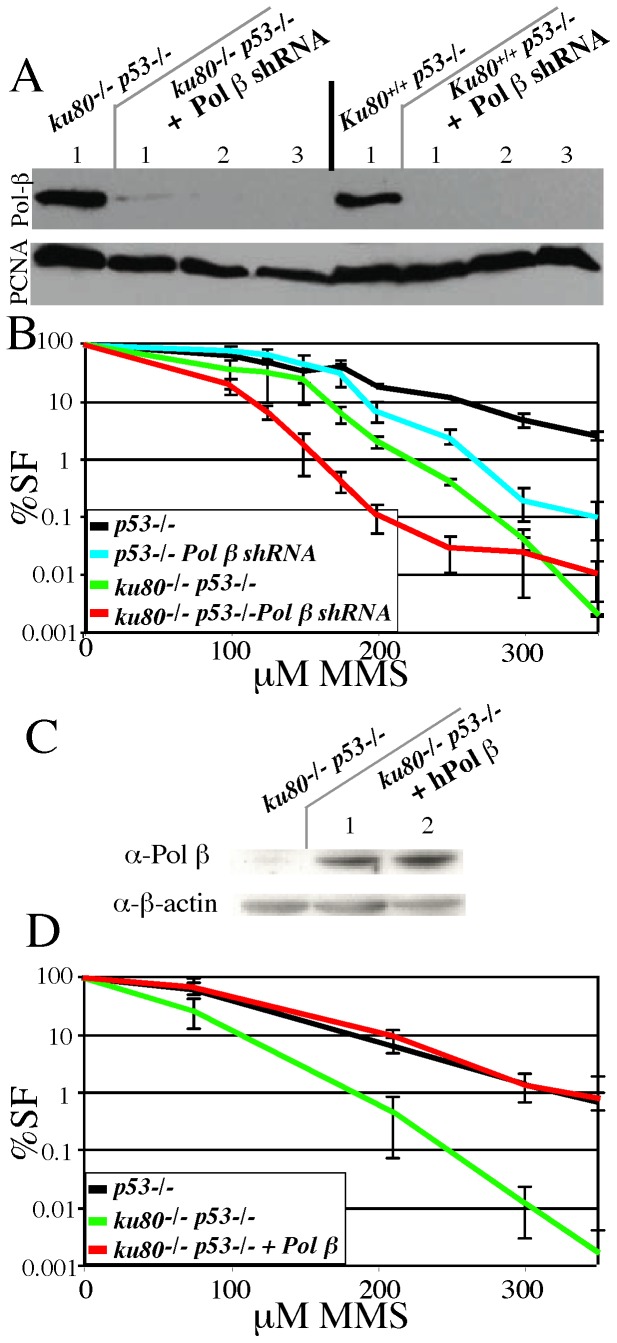
Epistatic analysis for Ku80 and Pol β.All cells are deleted for p53 (even controls) to avoid early replicative senescence. Shown is the average of three experiments. (A) Western showing RNAi knockdown of Pol β in p53-/- control and ku80-/- p53-/- fibroblasts that stably express a shRNA plasmid specific for mouse Pol β (three clones). PCNA was loaded to normalize for nuclear protein levels. The expression of endogenous Pol β in the shRNA-transduced cell lines was undetectable by immunoblot, consistent with our earlier reports for this mouse Pol β -specific shRNA [30]. (B) Dose-response to MMS for p53-/- control and ku80-/- p53-/- fibroblasts with and without mouse Pol β shRNA expression. (C) Western showing increased Pol β levels for the ku80-/- p53-/- fibroblasts that stably express a Pol β expression plasmid (two clones). Beta-actin was loaded to normalize for cellular protein levels. (D) Pol β -overexpression rescues Ku80-mutant phenotype for MMS.